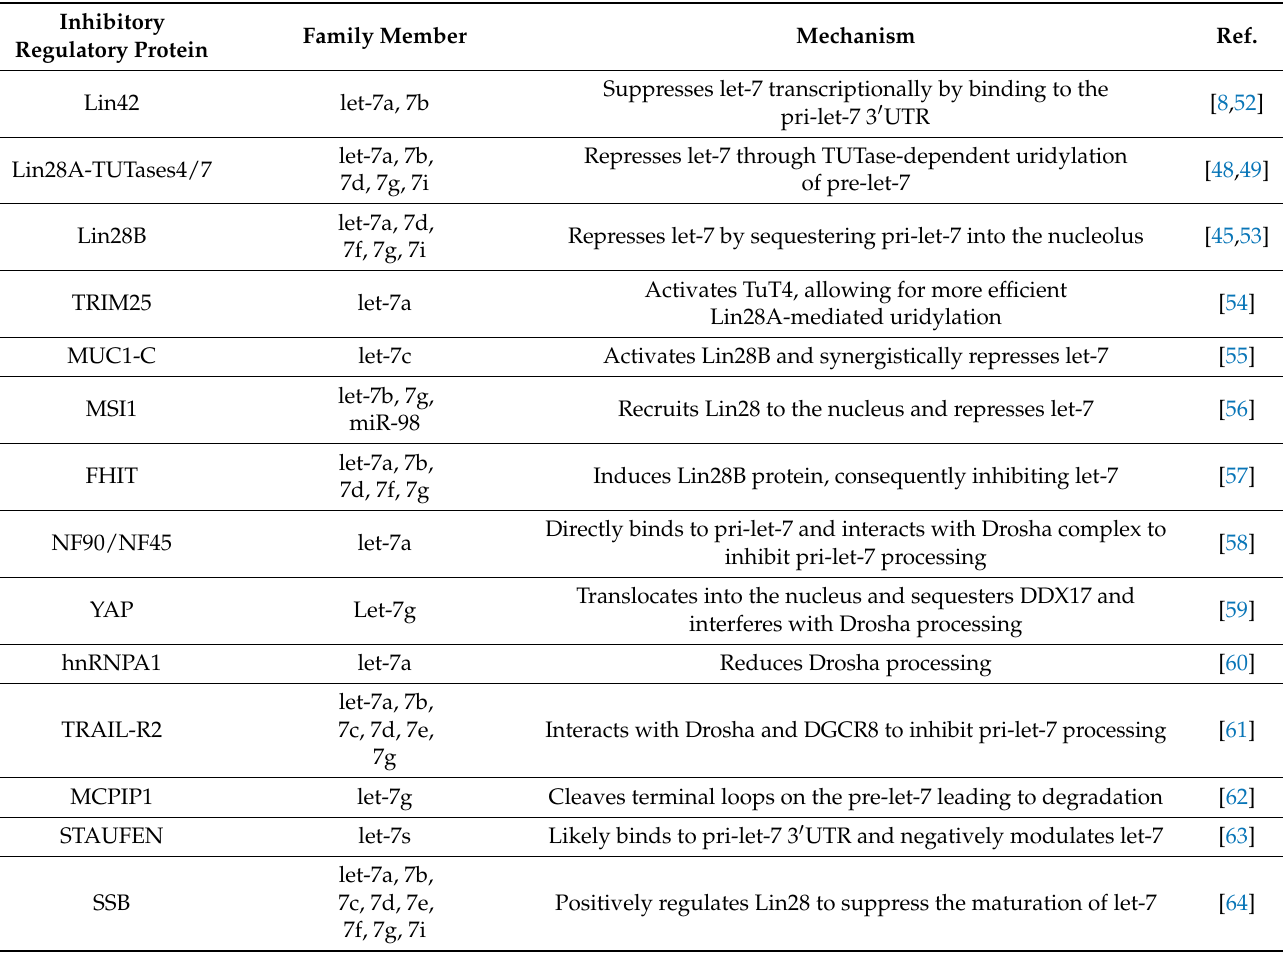
Table 1. Some known regulatory proteins that affect let-7 biogenesis through different